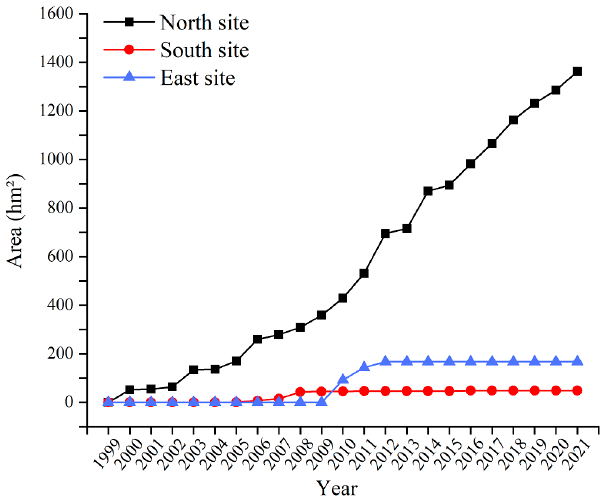
Figure 6. Areas of North site, South site, and East site.